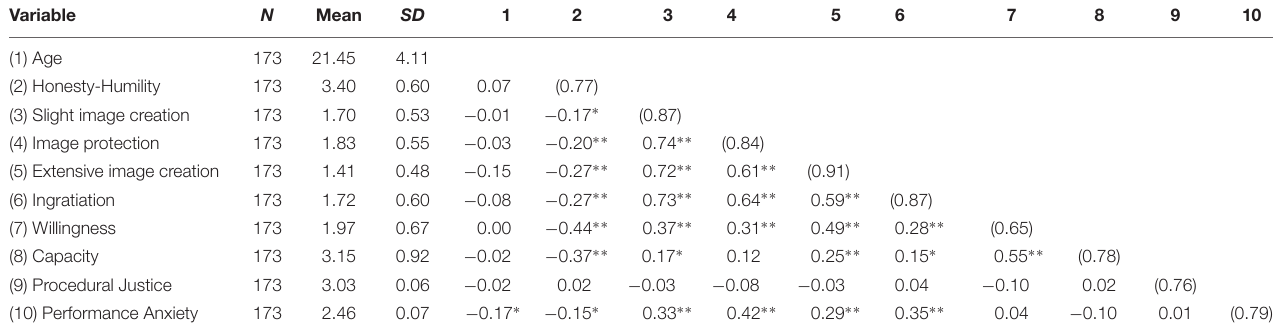
TABLE 2 | Descriptive statistics and correlations. Variable